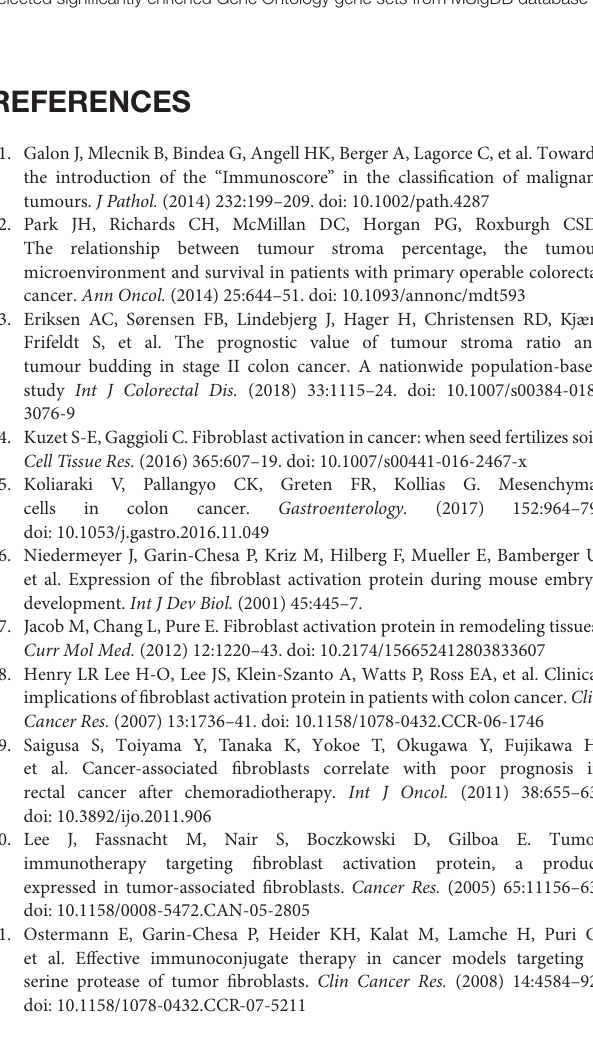
Supplementary Figure 4 | Correlation of FAP expression with (A) immune markers; (B) epithelial to mesenchymal transition (EMT) markers and (C) angiogenesis markers. Statistical analyses were performed using Pearson correlation tests. Supplementary Figure 5 | Boxplots show the enrichment scores of each cell type between FAP -high and FAP -low groups in the TCGA CRC cohort, as defined by xCell. p-values were calculated using t-tests. Supplementary Table 1 | Univariate and multivariate Cox regression analyses for the effect of FAP protein expression and clinicopathological parameters on overall survival in the TMA cohort. Supplementary Table 2 | Univariate and multivariate Cox regression analyses for the effect of FAP mRNA expression and clinicopathological parameters on overall survival in the TCGA